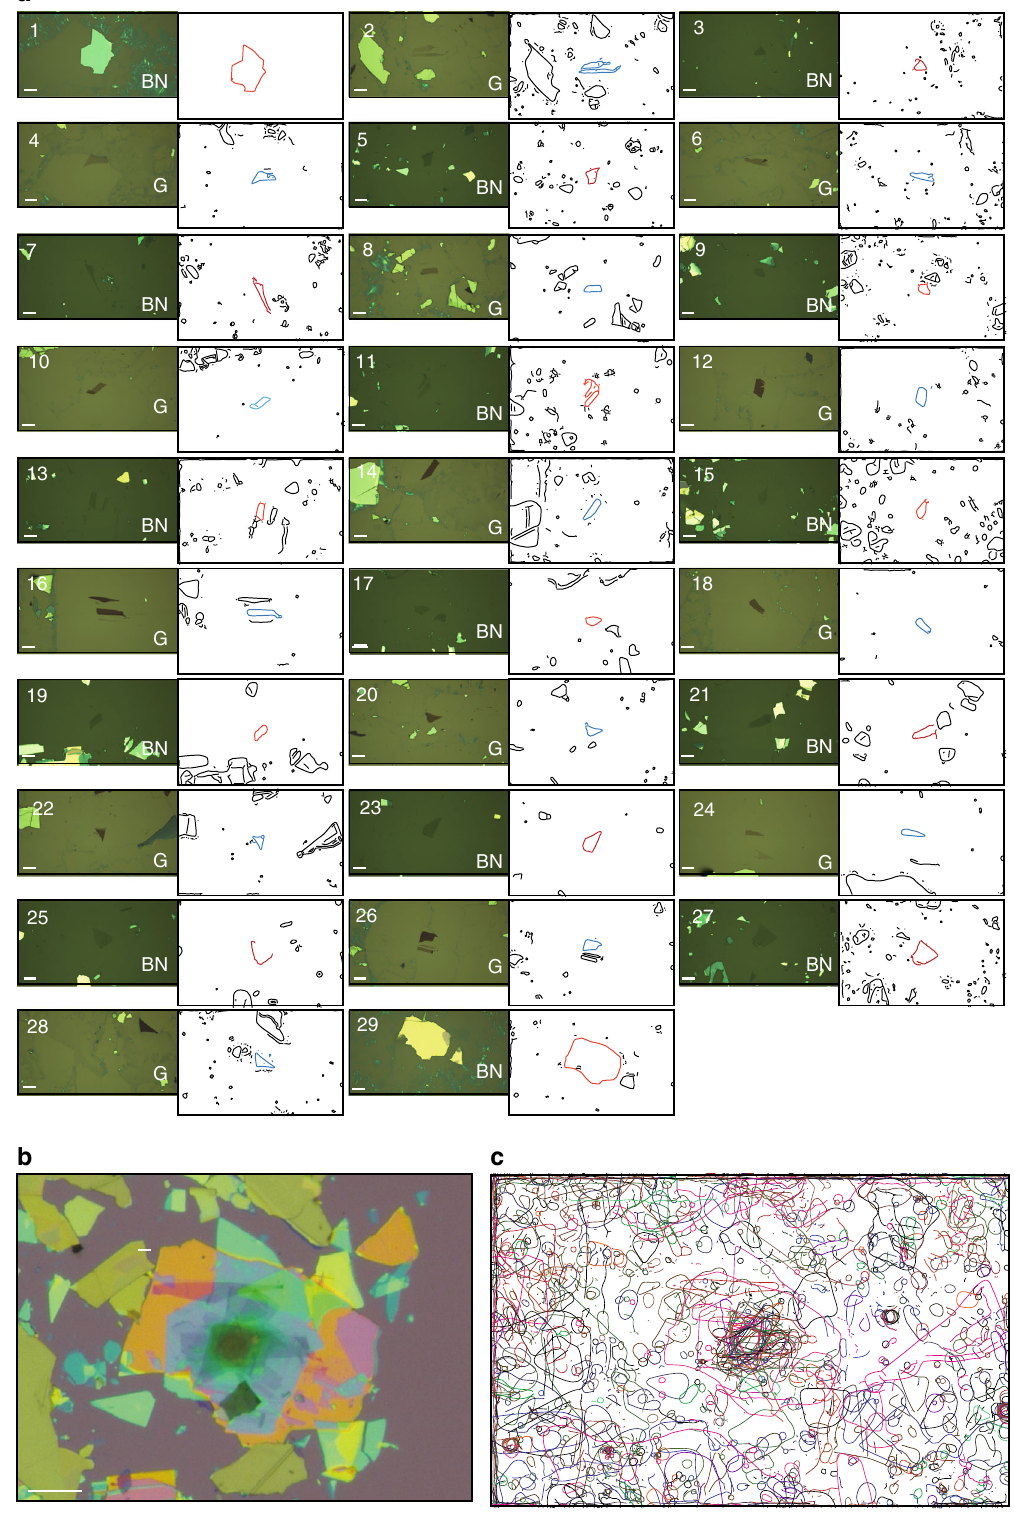
Fig. 2 Van der Waals superlattices comprising 29 alternating layers of graphite and hBN. a Left panels: Optical microscope images of graphite (G) and hBN utilized to assemble vdW heterostructures. Right panels: The vector-drawing line-edges of G and hBN fl akes extracted from the edge detection algorithms applied to the optical microscope images taken in the stamping apparatus before pick-up. The scale bars correspond to 20 μ m. b Optical microscope image of G/hBN vdW superlattice structures. The scale bar corresponds to 20 μ m. c Superimposed edges of G and